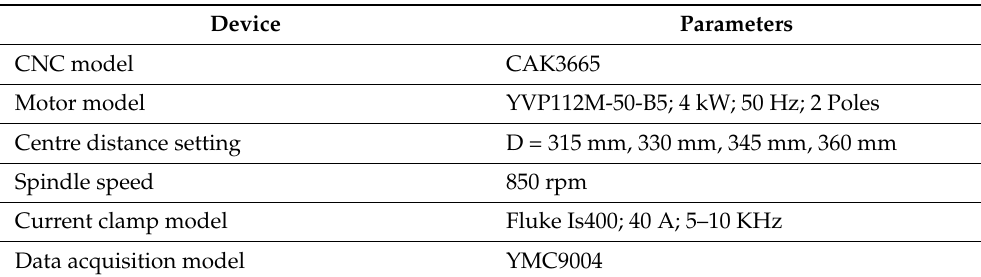
Table 3. Parameters used in simulations with